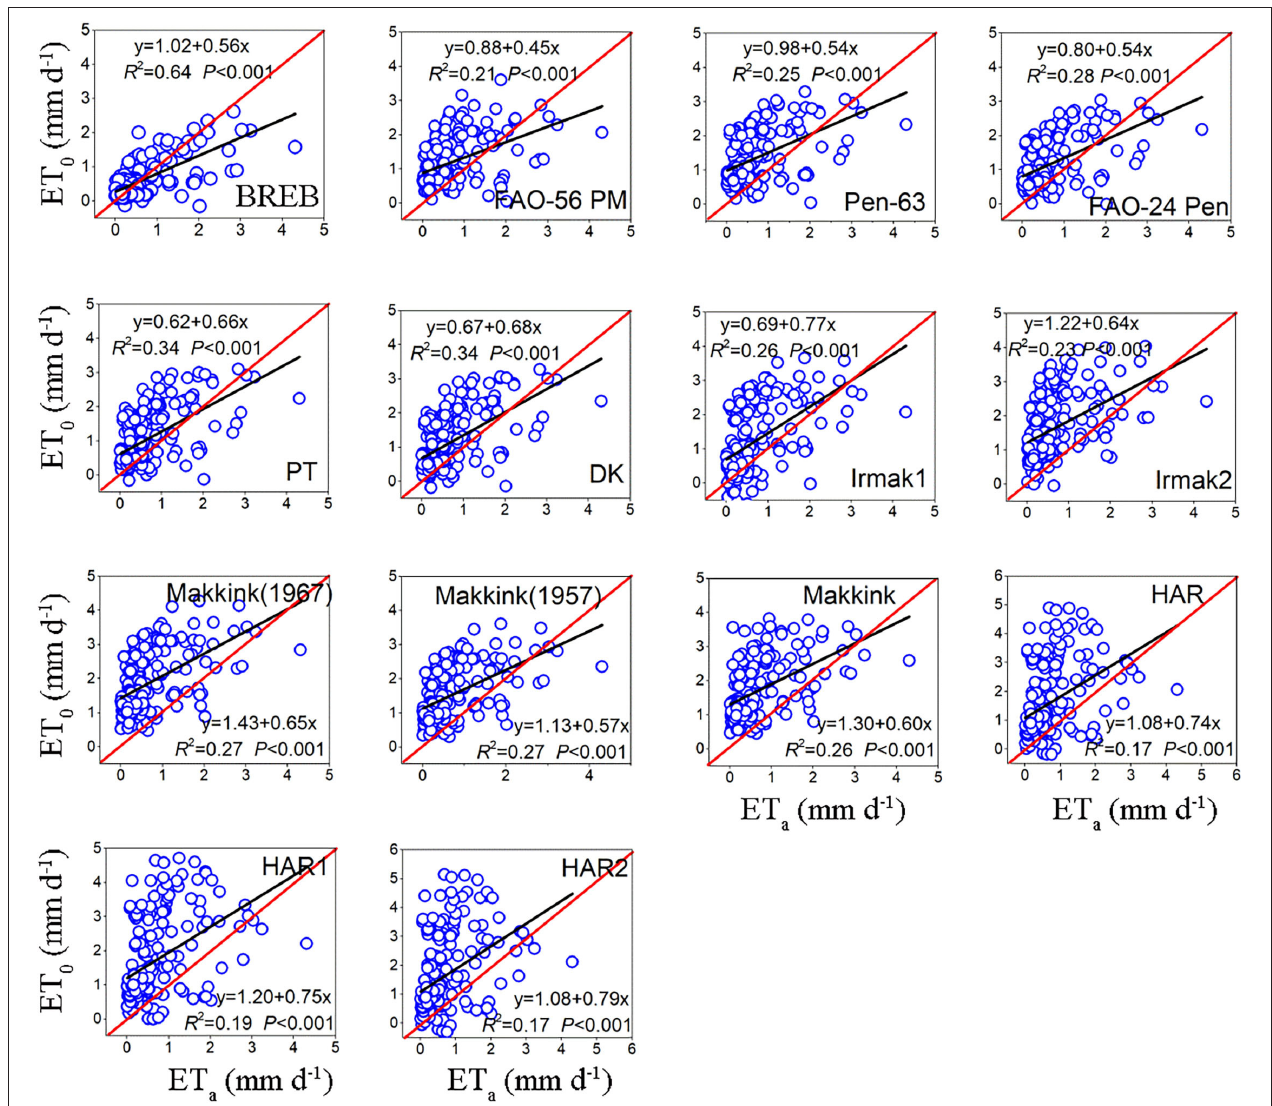
FIGURE 6 | The relationship between daily ET 0 of model estimates and ET a of lysimeter measurements during the nongrowing season (data points =